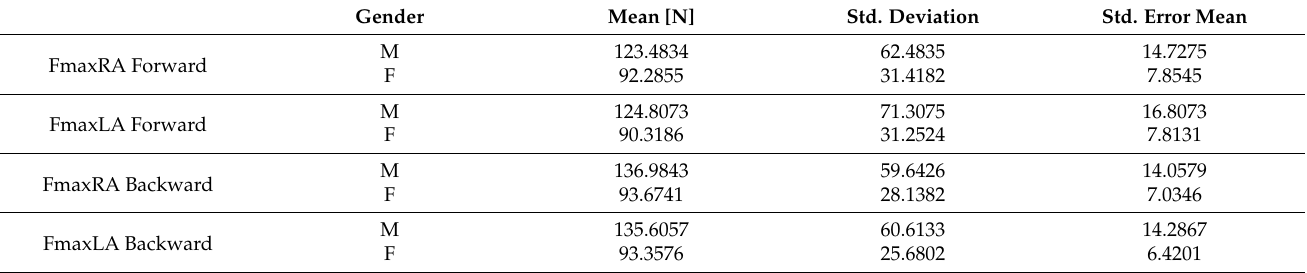
Table 3. Data descriptive statistics.